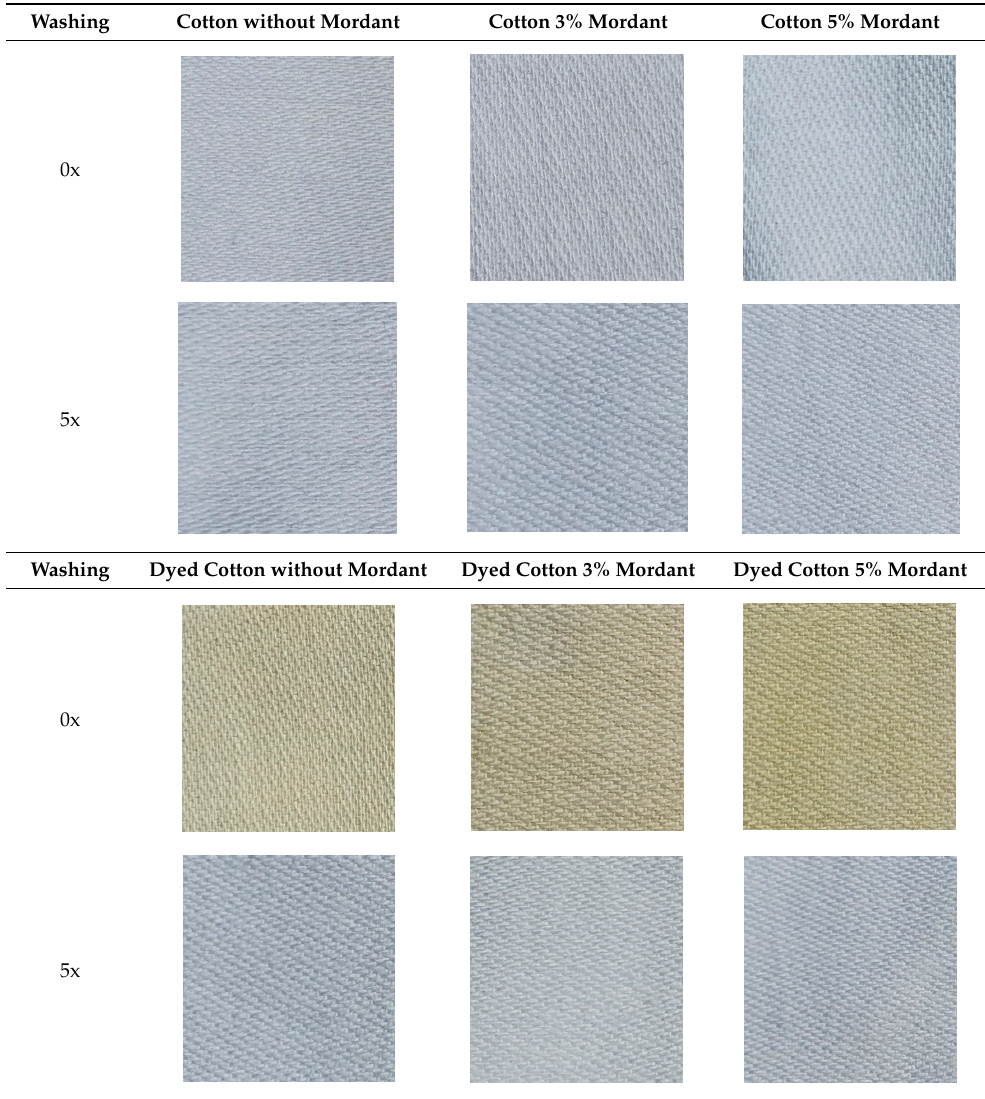
Table 11. Visual assessment of colorfastness to washing.